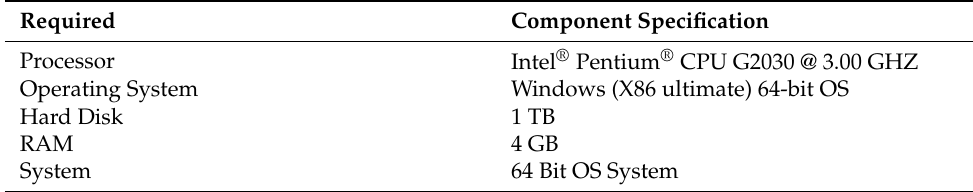
Table 2. Hardware